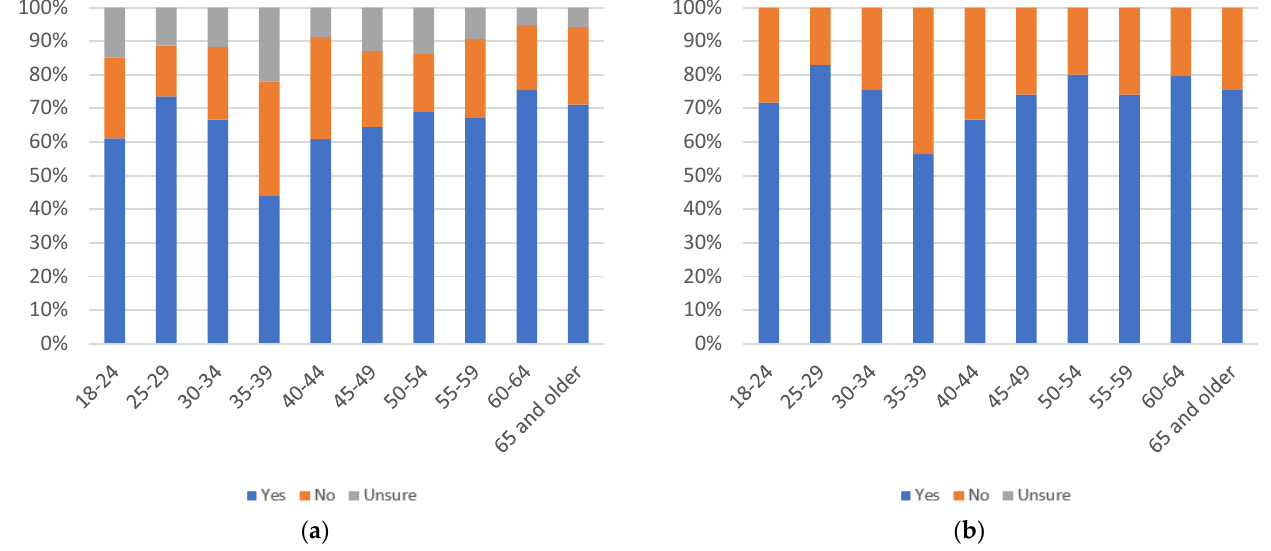
Figure 59. Label use, by age group: ( a ) with uncertain respondents (left) and ( b ) without uncertain respondents (right).